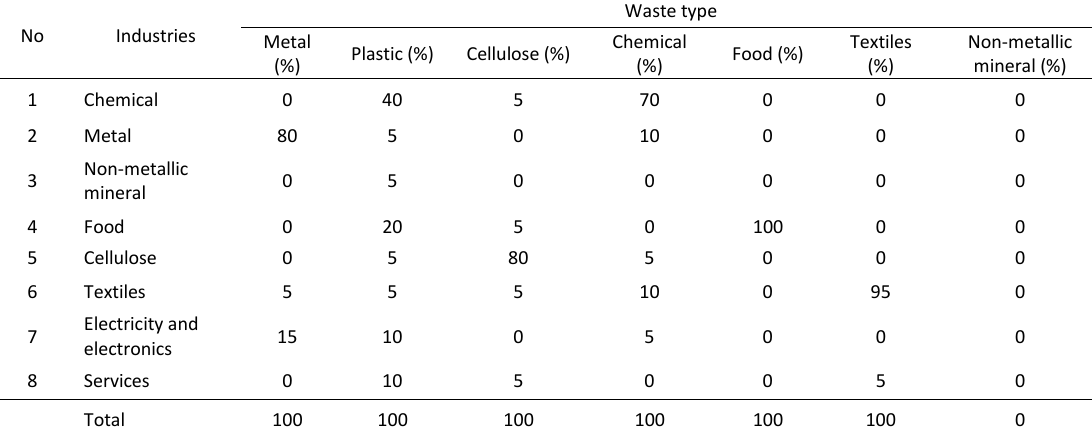
Table 2: The share of each industry in producing various waste types